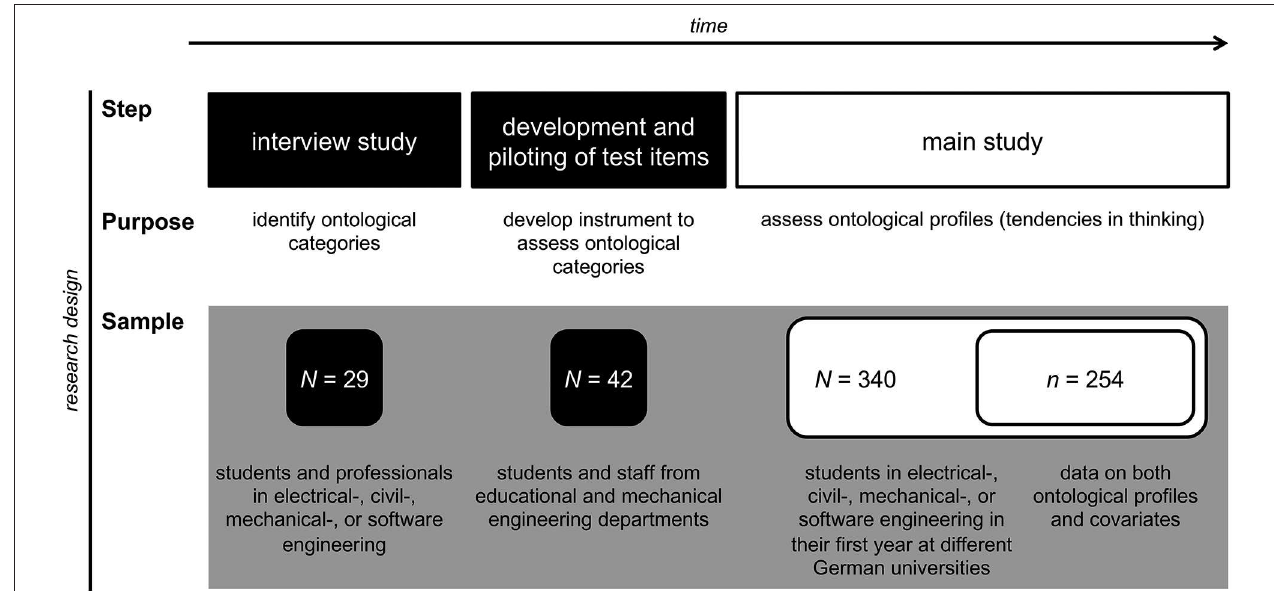
FIGURE 2 | Schematic representation of the research design. Time flows from left to right. Corresponding information is vertically aligned. The first row provides information on the step within the research process, the second row on its purpose, and the third row on the samples examined in each step.